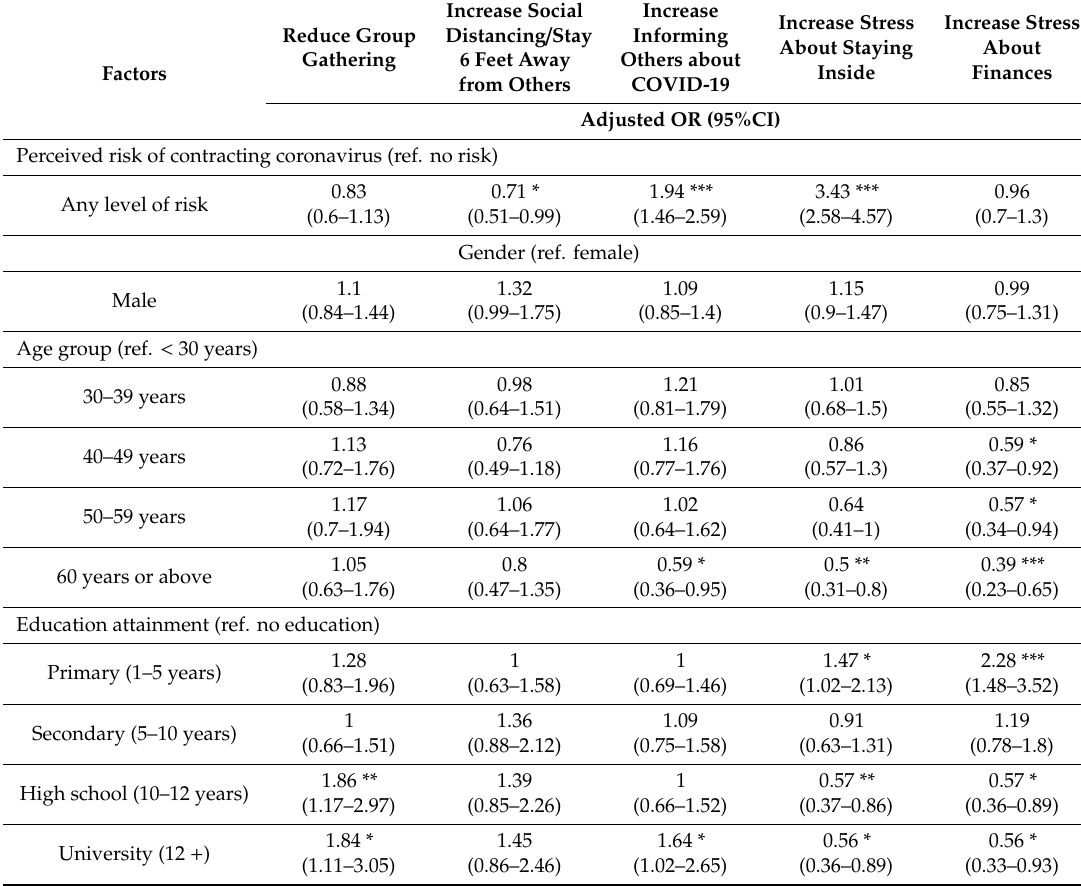
Table 5. Factor associated with changes in behavior and stress since lockdown adjusted for community-level fixed e ff ects, Tamil Nadu, India, May 2020. Factors